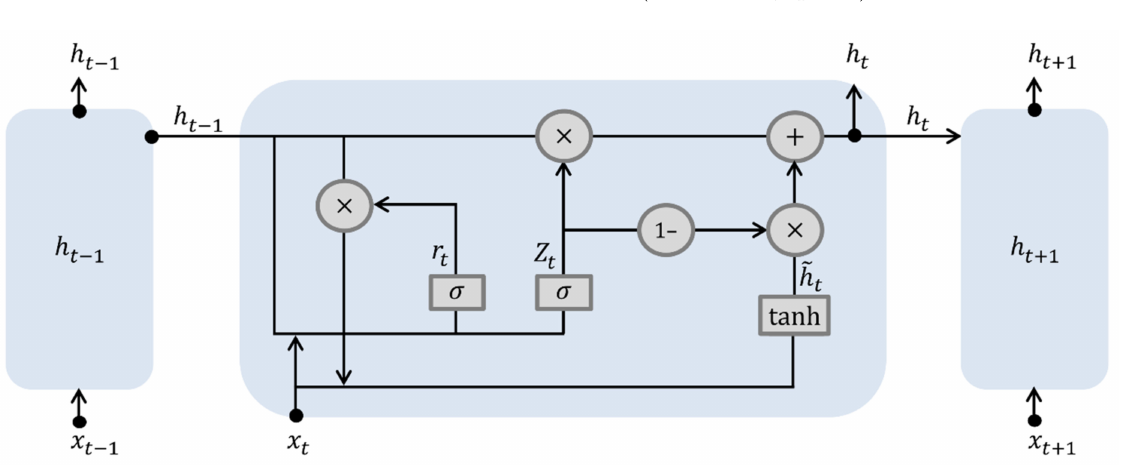
Figure 7. Schematic architecture of the